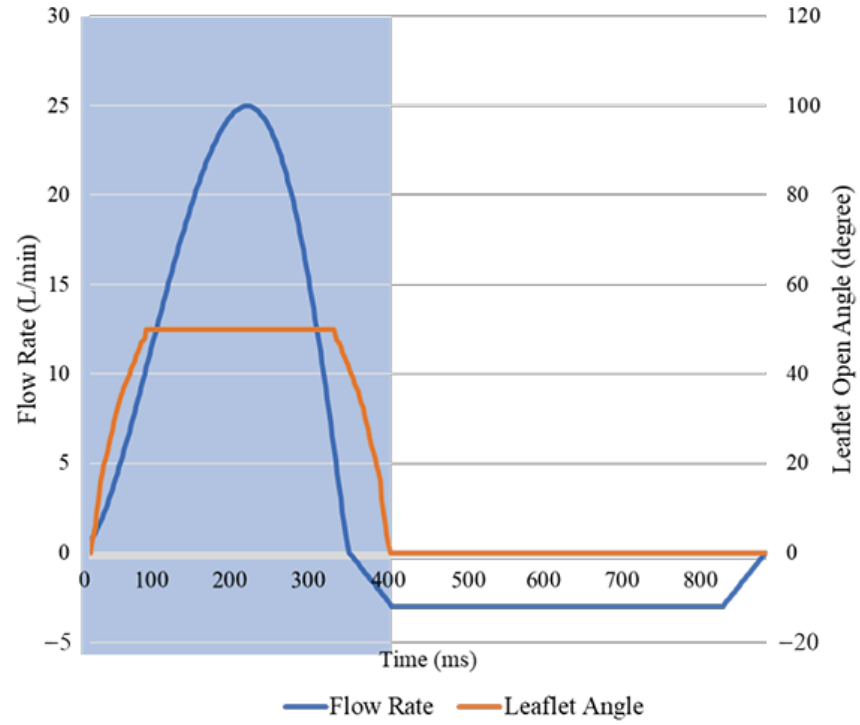
Figure 7. Flow rate pulse of the aorta inlet with the leaflet open angle changes [44]. Unstructured tetrahedral mesh technology was used for mesh division and perform- ing densification processing at hinge regions and leaflets to improve the resolution of key parts and obtain high-precision results. Figure 8 presents the grid structure of the computational domain. Five grid sets were used to perform grid-independent studies at peak systole. Grid-independent studies were performed using different grid sizes from 1,206,722 to 3,379,553 (Figure 9). It is not difficult to verify grid-independent velocities in grid-independent verification, but achieving grid independence in the computed WSS fields requires more nodes and may show errors even on grids that generate grid-independent velocity fields [45]. The WSS is obtained on the wall, and the results indicate that when the number of grids exceeds three million, the WSS does not increase significantly. The error is less than 2%. Three million grids were used in this study.